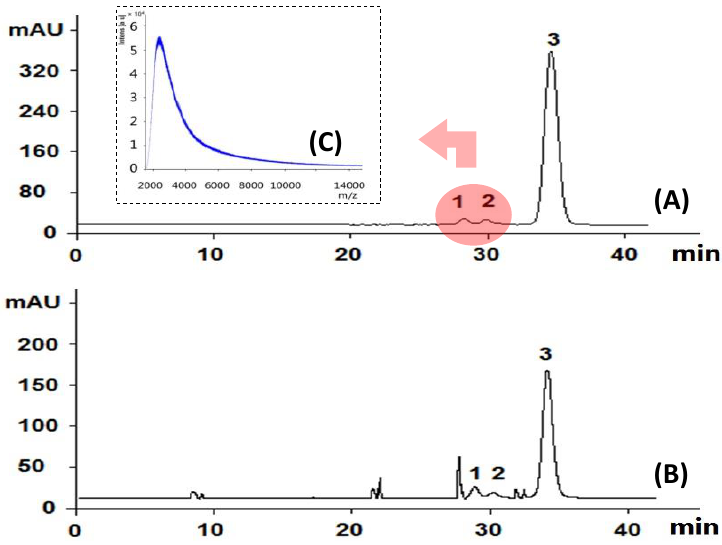
Figure 4. HPGPC analysis of SQI sample before ( A ) and after ( B ) acid hydrolysis; MALDI-TOF-MS analysis of peaks 1 and 2 ( C ) The determined small molecules contribute peak 3.